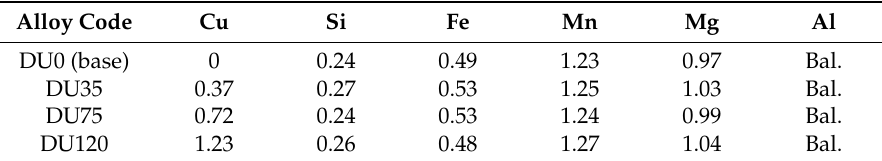
Table 1. Chemical composition of experimental alloys (wt.